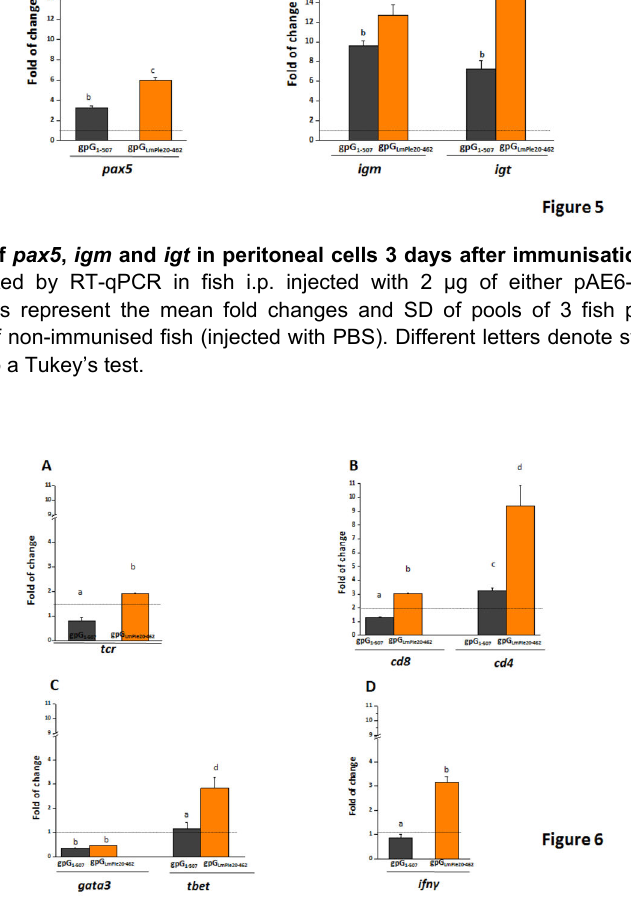
Figure 6. Transcripts levels of genes related to differentitation of T lymphocytes in peritoneum cells at 3 days after immunisation. Levels of tcr (A), cd4 and cd8 (B), gata3 and tbet (C) and ifnγ (D) gene expression estimated by RT-qPCR in fish i.p. injected with 2 µg of pAE6-gpG (black bars) or pAE6-gpG (orange bars). Bars represent the mean fold changes and 1-507 LmPle20-462 SD of pools of 3 fish per group. Fold increases were calculated relative to the level of non-immunised fish (injected with PBS). The differences among groups were analysed by ANOVA with a post hoc test (Tukey’s). Different letters denote degrees of statistical significance in the differences between the groups according to a Tukey’s test. The groups marked with “a” did not show statistically significant differences from control